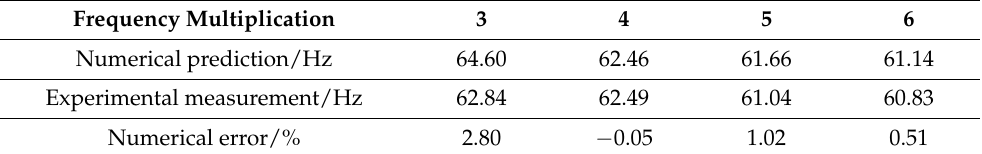
Table 2. Experimental and numerical analysis of blade vibration frequency results at each octave.